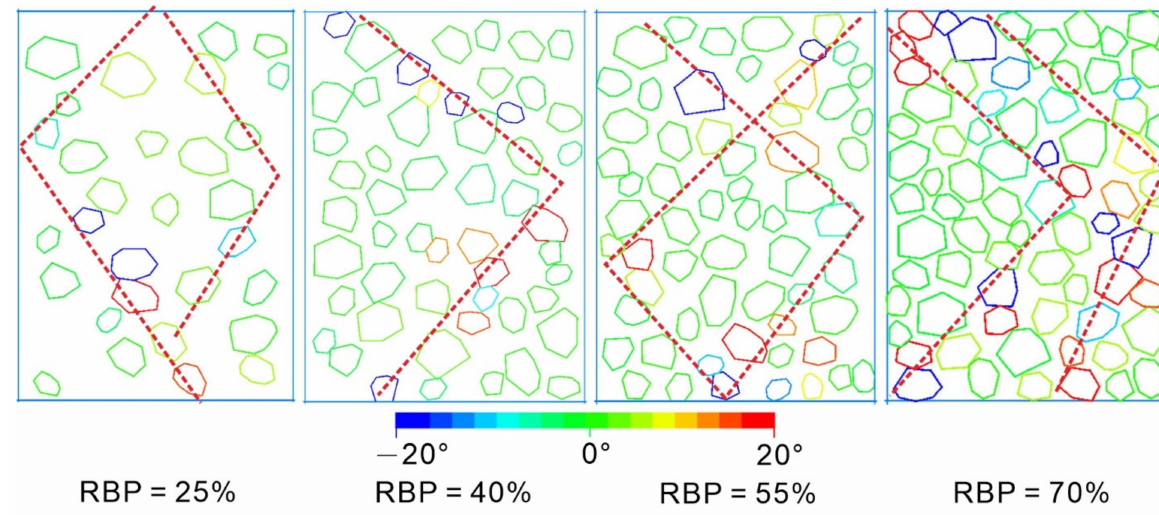
Figure 9. Rock rotations in numerical S-RM specimens.